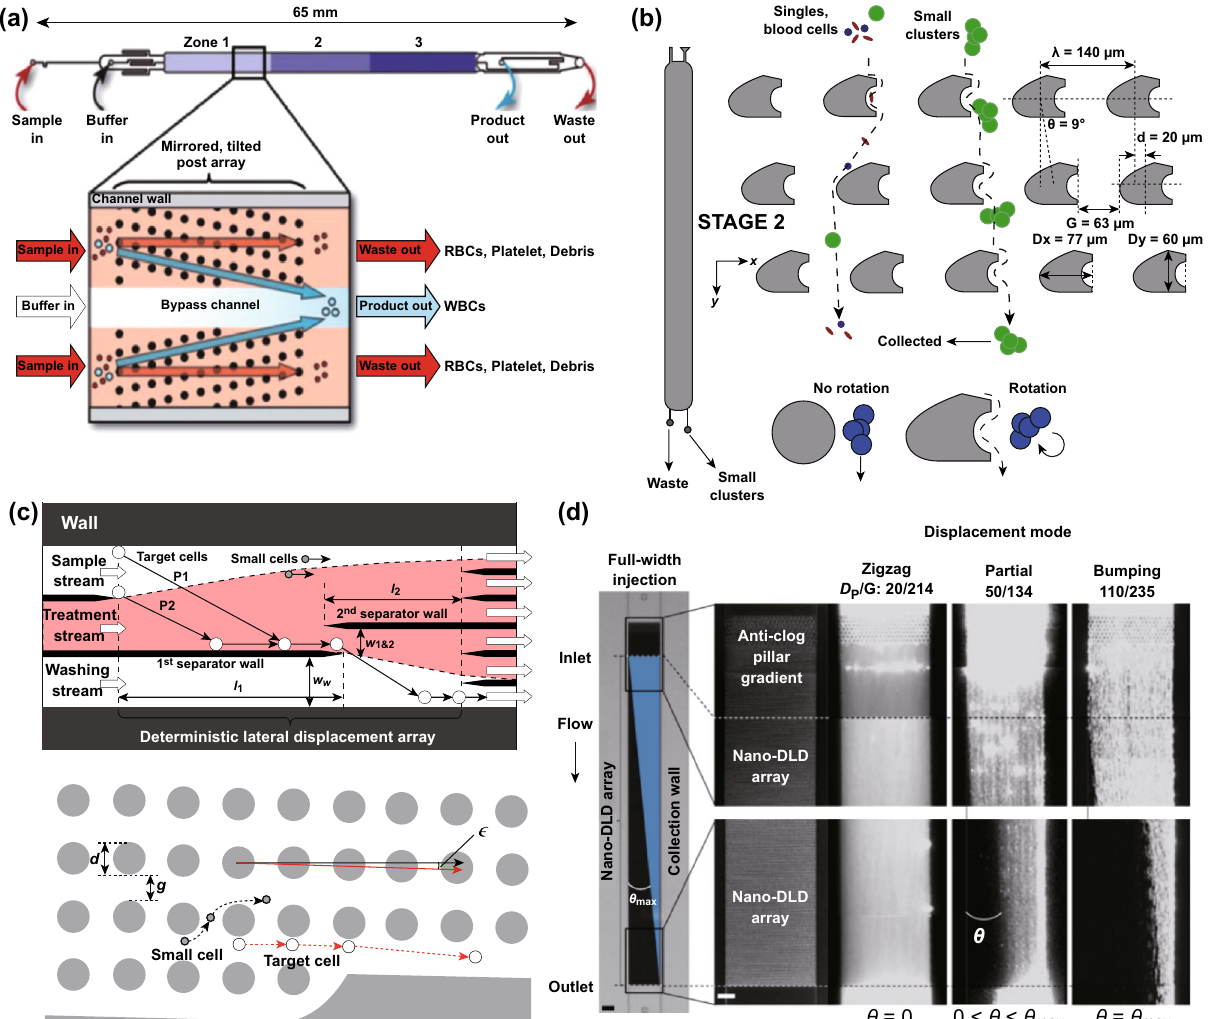
Fig. 11 Applications of size-based DLD separation. a The design of the microfluidic DLD mirrored array for automated leukocyte processing [84]. b The two-stage DLD arrangement based on both the size and asymmetry for CTC clusters separation [41]. c The on-chip microfluidic DLD for chemical treatment and washing [85]. d The condenser array in a nano-DLD shows the zigzag, intermediate, and bumping modes for different nanoparticle diameters and gap sizes [20]. Figure panels reproduced from Ref. [84] with permission from Wiley, copyright 2016, Ref. [41] with permission from Springer Nature (CC BY 2017), Ref. [85] with permission from AIP Publishing, copyright 2015, Ref. [20] with per- mission from Springer Nature, copyright